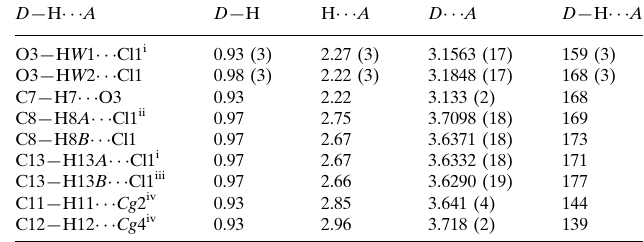
Hydrogen-bond geometry (A ˚ , (cid:4) ). D —H (cid:2)(cid:2)(cid:2)